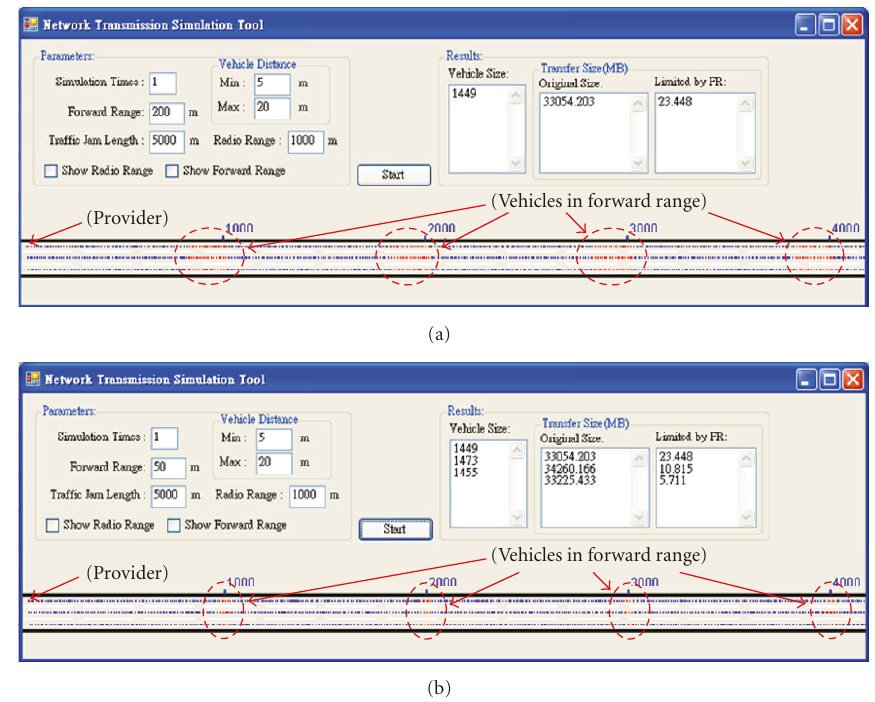
Figure 8: The screen shot of the network transmission simulation tool (a) forward range = 200 m; (b) forward range = 50